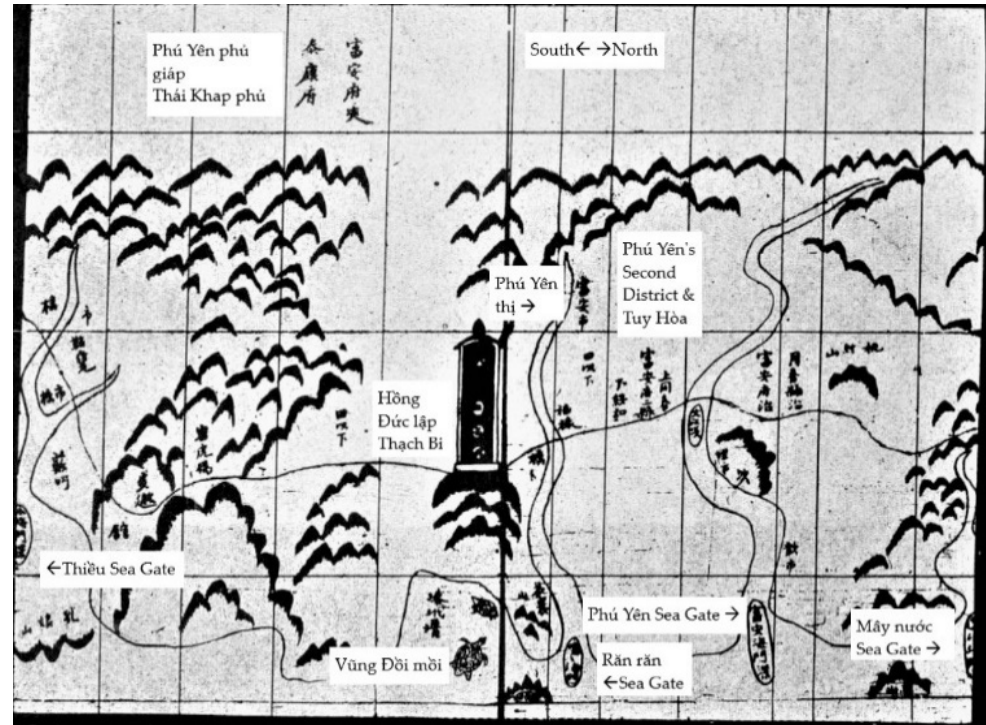
Figure 6. Bình Nam Đồ panel of Phú Yên province in classical Vietnamese, with romanized Viet- Figure 6. B ì nh Nam Ð ồ panel of Ph ú Y ê n province in classical Vietnamese, with romanized Vietnamese namese added to key locations (adapted from B ử u et al. 1962). added to key locations (adapted from B ử u et al.